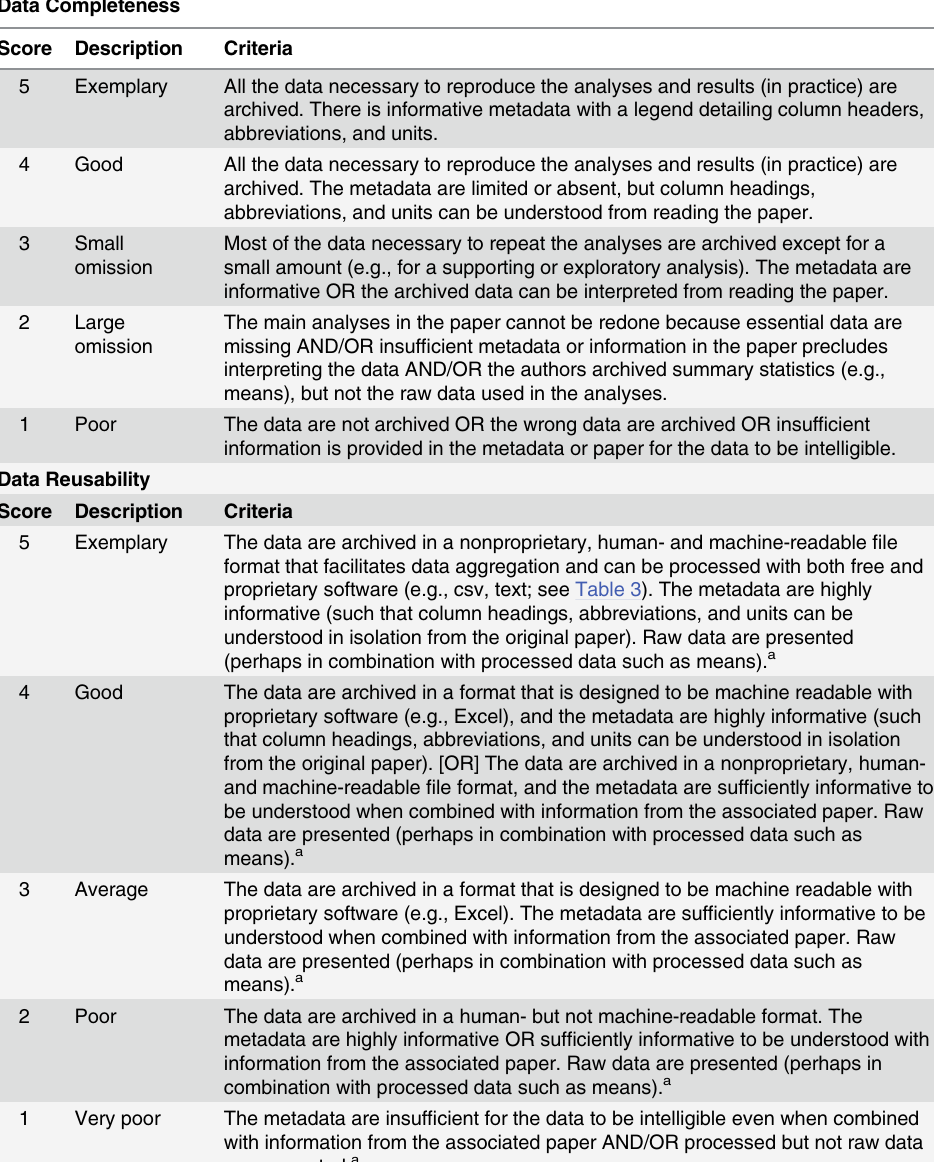
Table 2. Data completeness and reusability assessment. Scoring system and criteria used to assess data completeness and reusability of 100 studies with data archived in the public repository